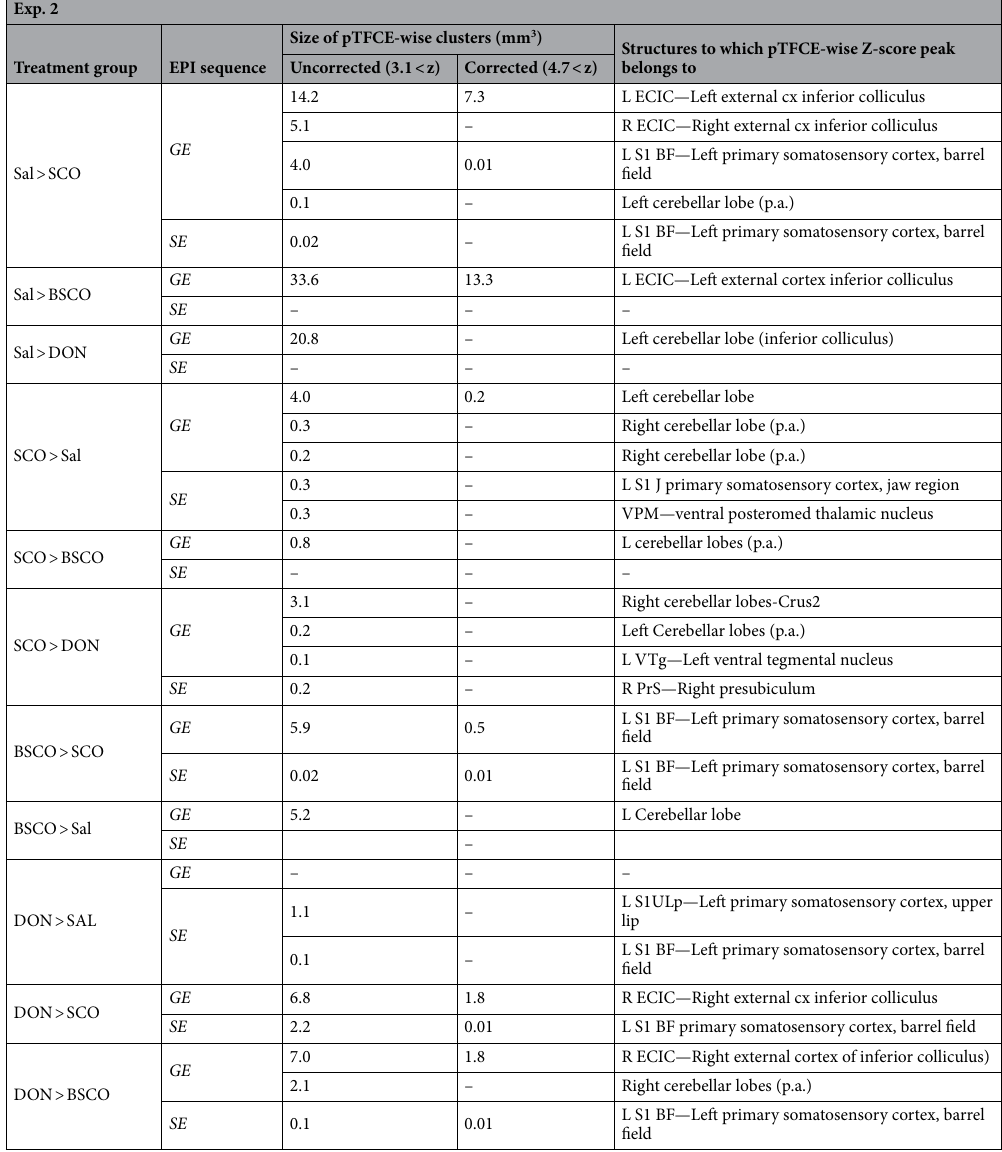
Table 1. Evoked activation differences in medetomidine-isoflurane combined anesthesia with GE EPI and SE EPI sequences (the size of clusters in mm 3 and the brain structures to which Z-score (pTFCE statistical inference, p = 0.05 via GRF theory base FWER) peaks belong to). N = 62; 15, 16, 16, 15 of Sal, SCO, BSCO, DON, respectively. p.a. stands for probable artefact, as our gradient echo images are not accurate enough around the cerebellum to firmly conclude the